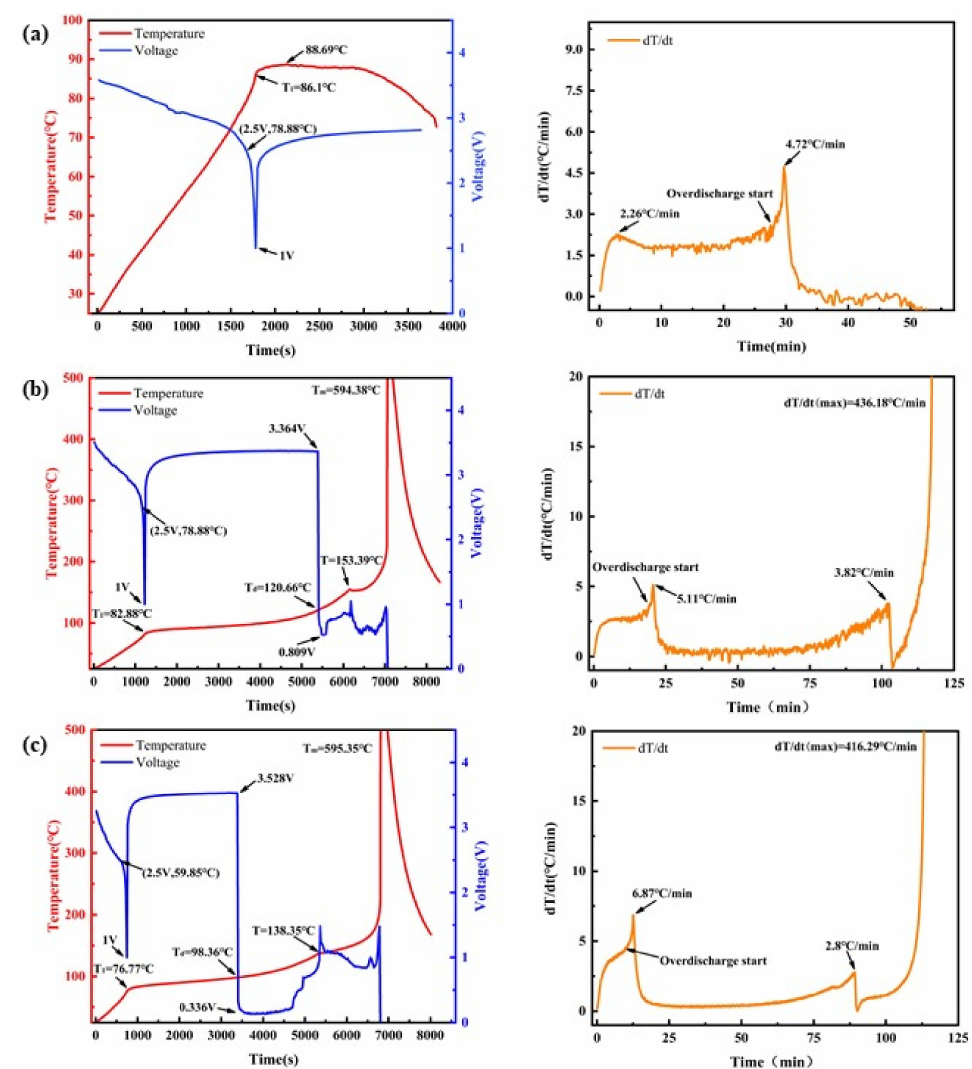
Figure 6. Temperature, voltage, and temperature rise rate (dT/dt) variation of -type NCM811 batteries with ( a ) 100% SOH, ( b ) 79.6% SOH and ( c ) 50.9% SOH in the adiabatic